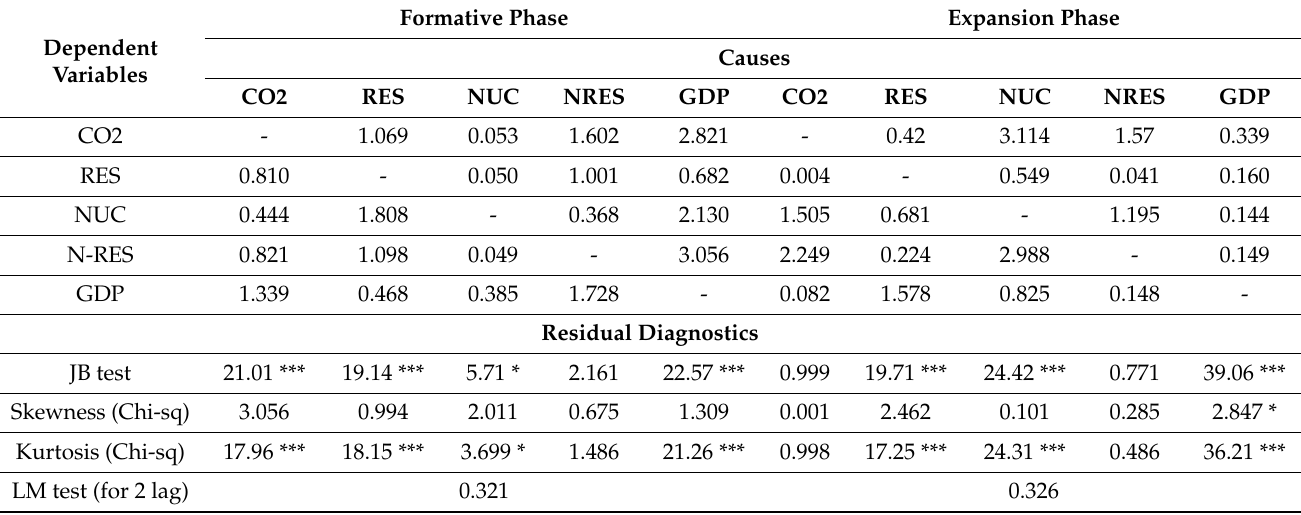
Table A4. Granger causality test results and residual